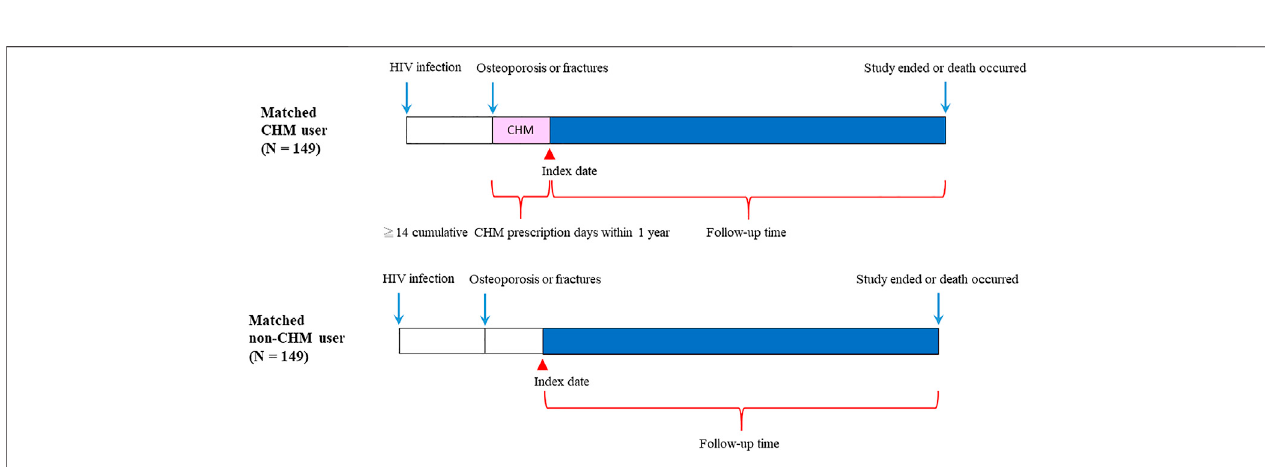
FIGURE 2 | Follow-up times of CHM and non-CHM users in HIV-infected patients with osteoporosis or fractures. CHM, Chinese herbal medicine.